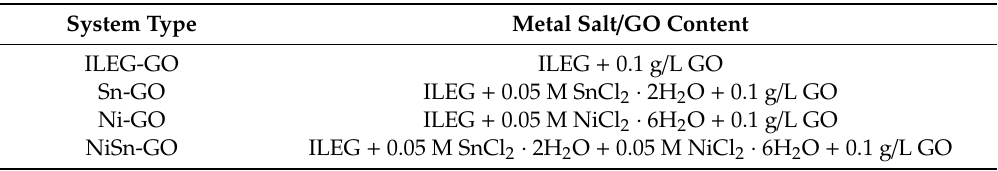
Table 1. The composition of electrolytes for cyclic voltammetry investigations .